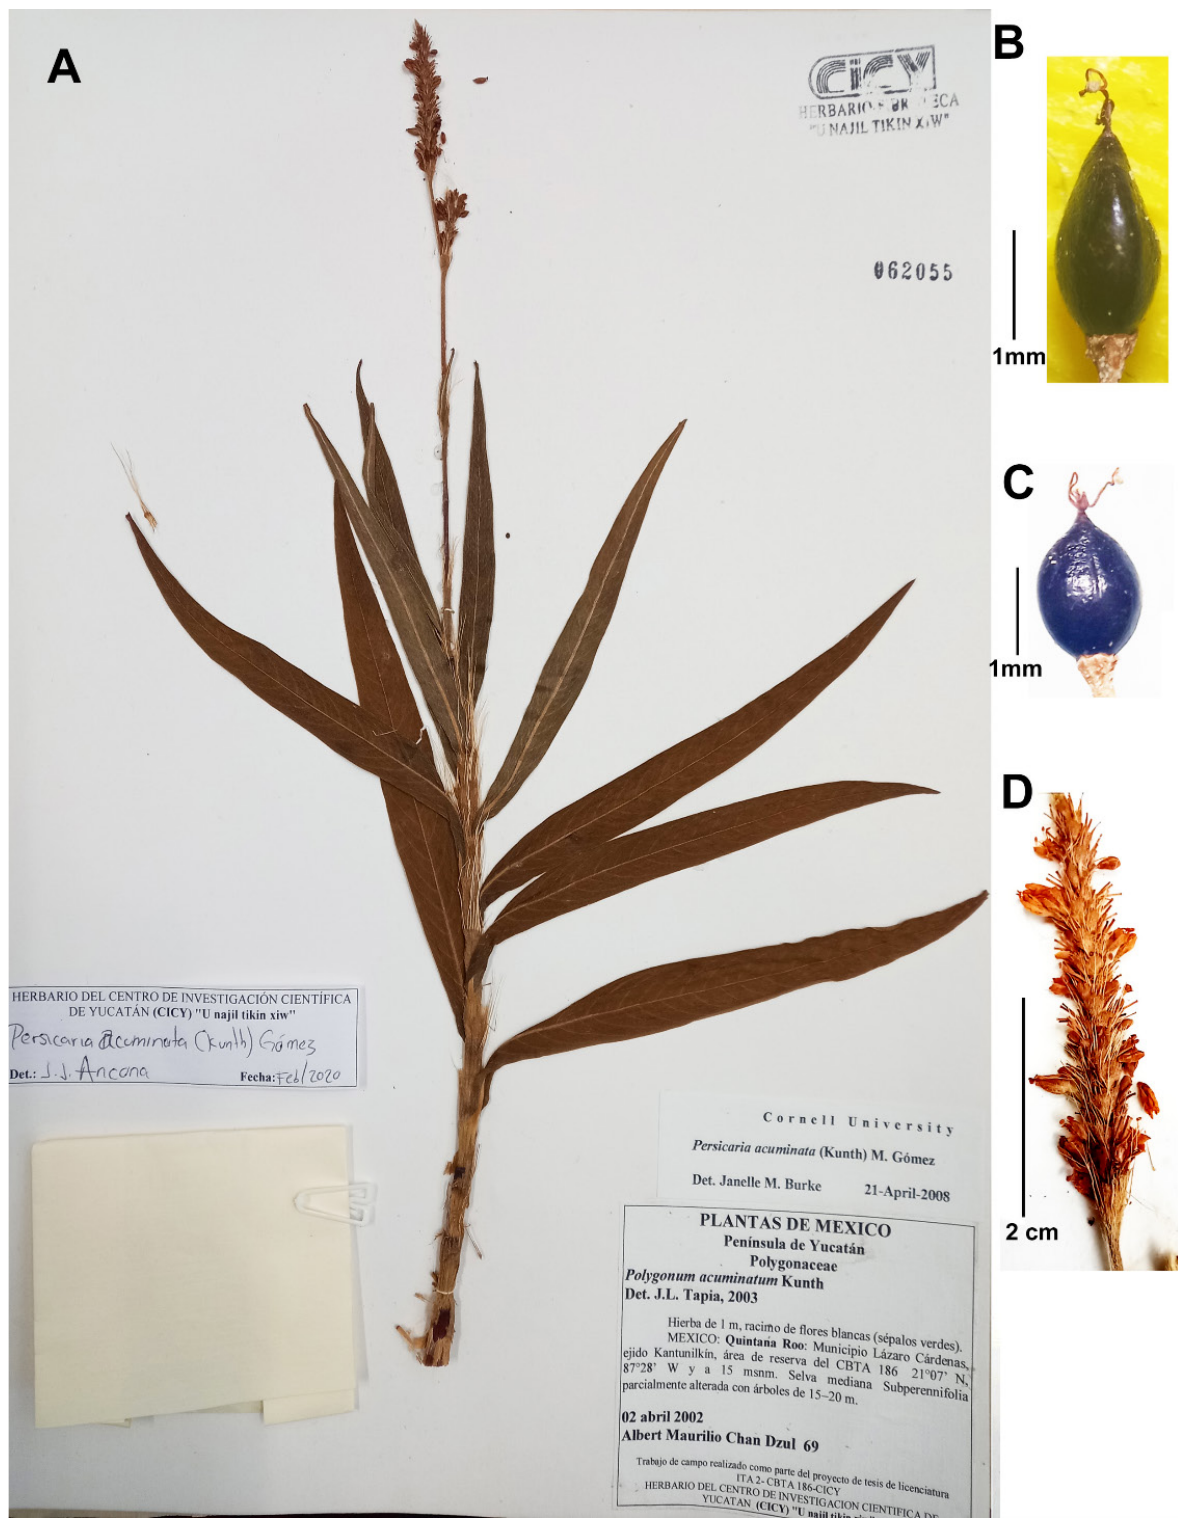
Figure 1. Persicaria barbata. A. Specimen Chan-Dzul 69 (CICY). B. Biconvex achene, in dorsal view. C. Biconvex achene, in ventral view. D. Inflorescence details: ochreolae strigose, setaceous, accrescent perianth with stamens